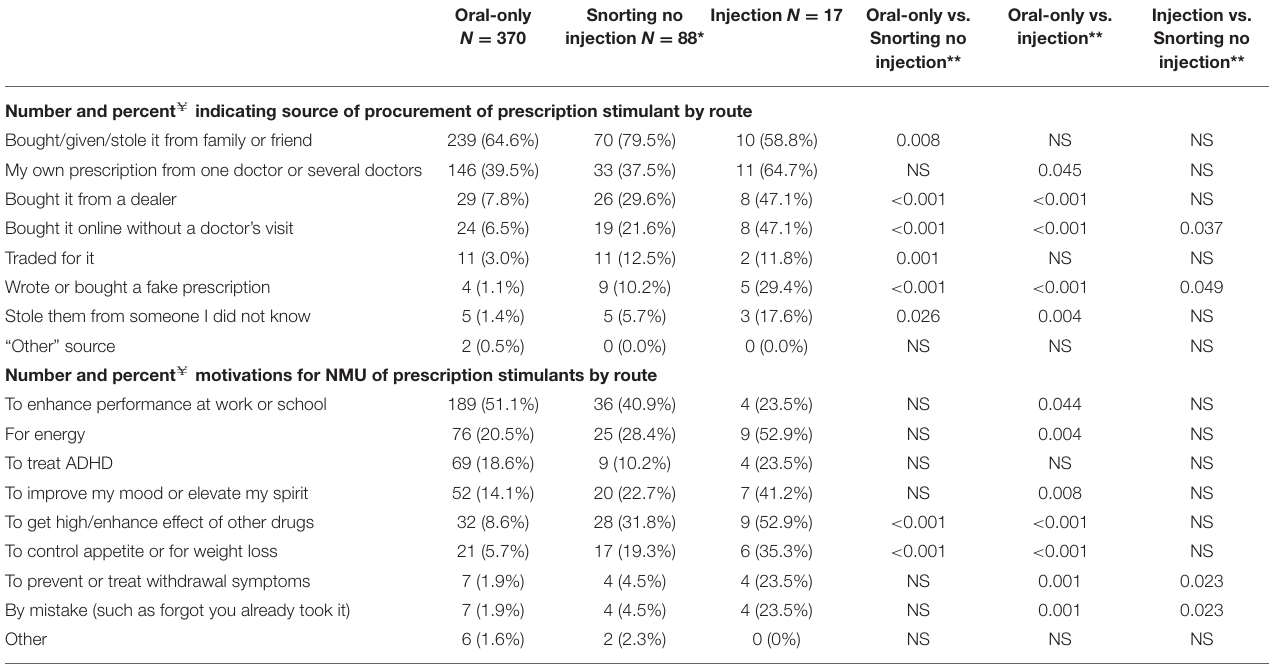
TABLE 3 | Source of procurement and motivations for NMU of prescription stimulants by route.